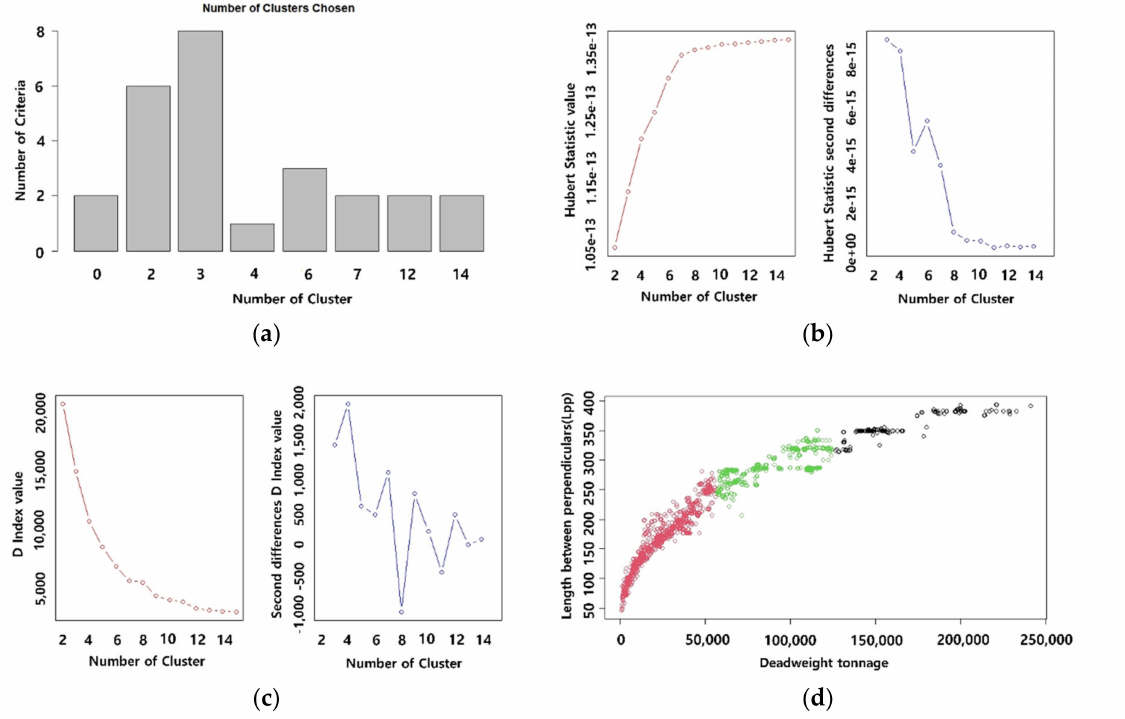
Figure 9. Results of k -means clustering on container ship deadweight tonnage–length between perpendiculars (m). ( a ) Number of clusters selected by NbClust; ( b ) Hubert statistic values; ( c ) D index value; ( d ) scatter plot clustered into three